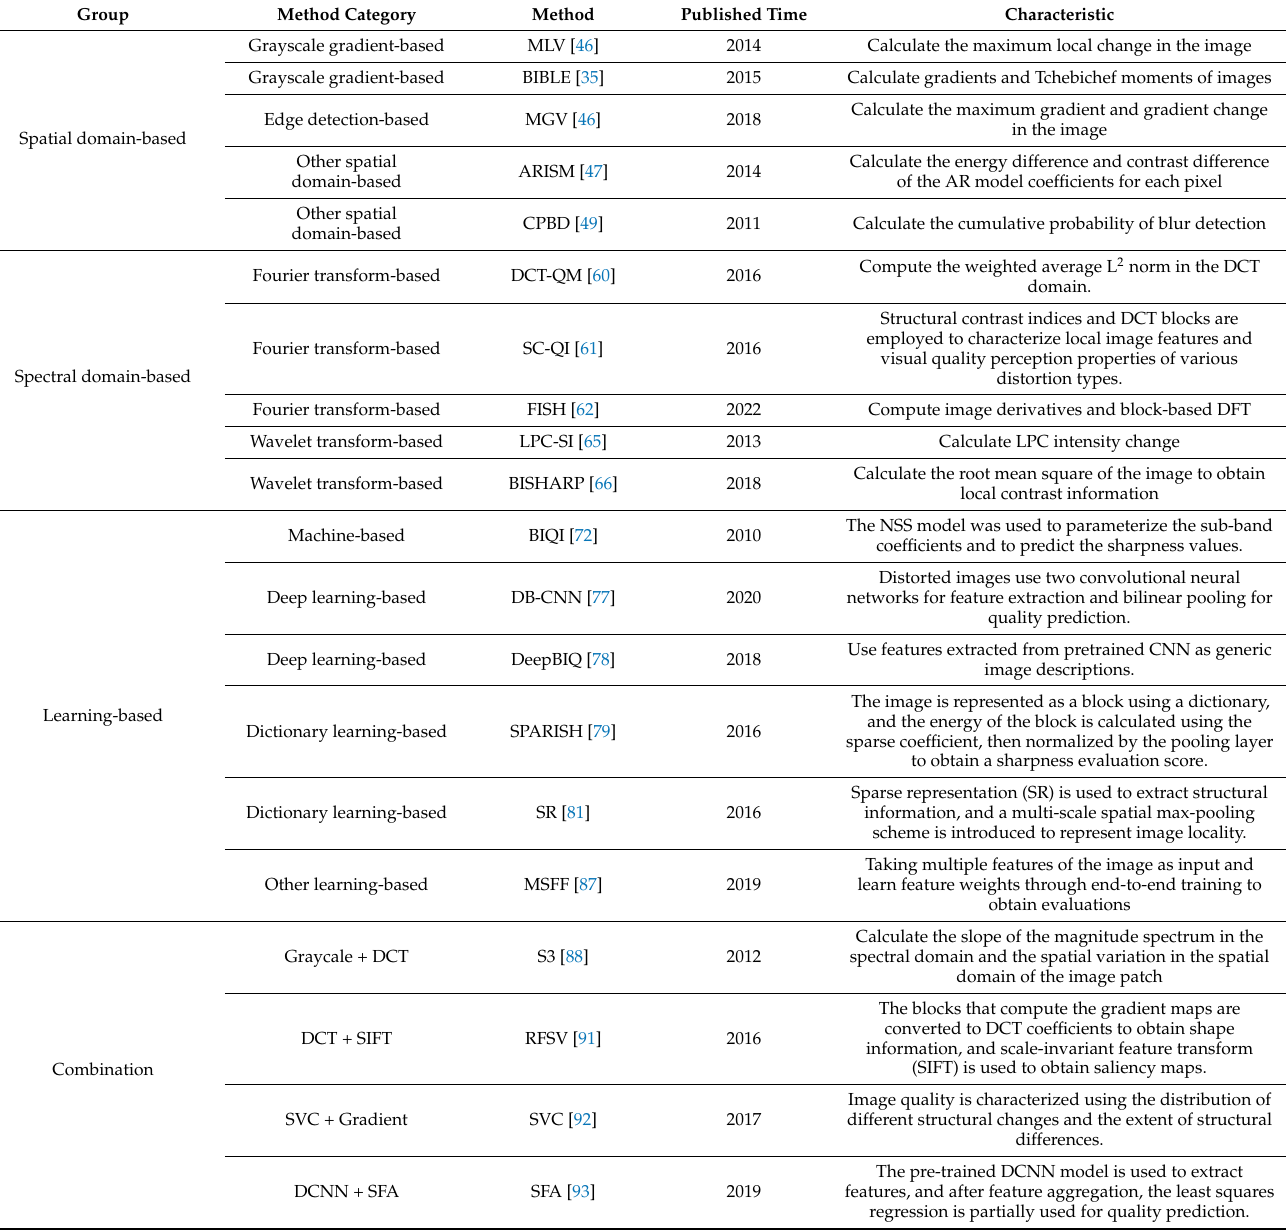
Table 3. Specific information of different methods for